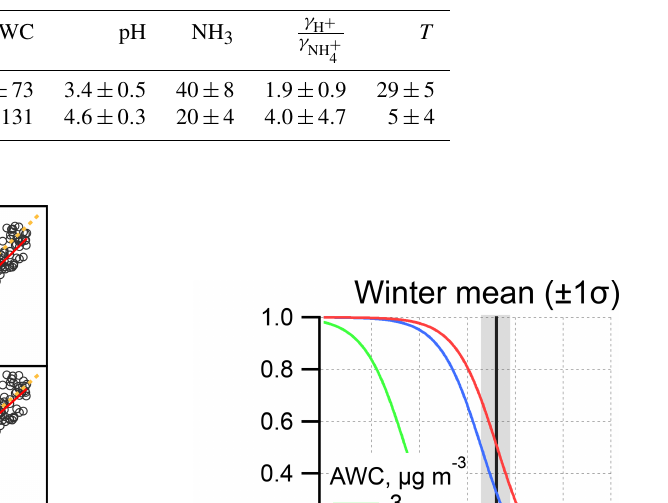
γ H + , and NH 3 (µgm − 3 ) during the haze period. γ NH + 4